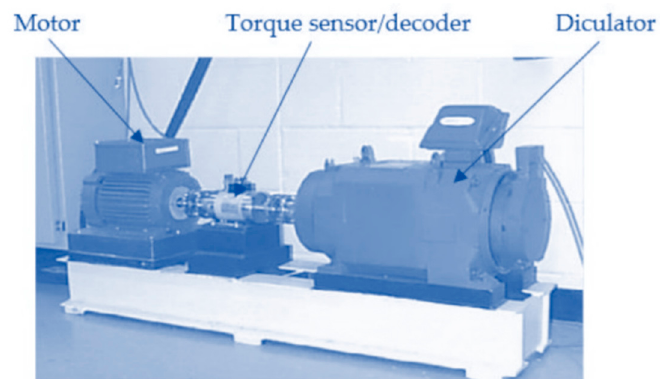
Figure 5. Relationship between system parameters and output SNR.